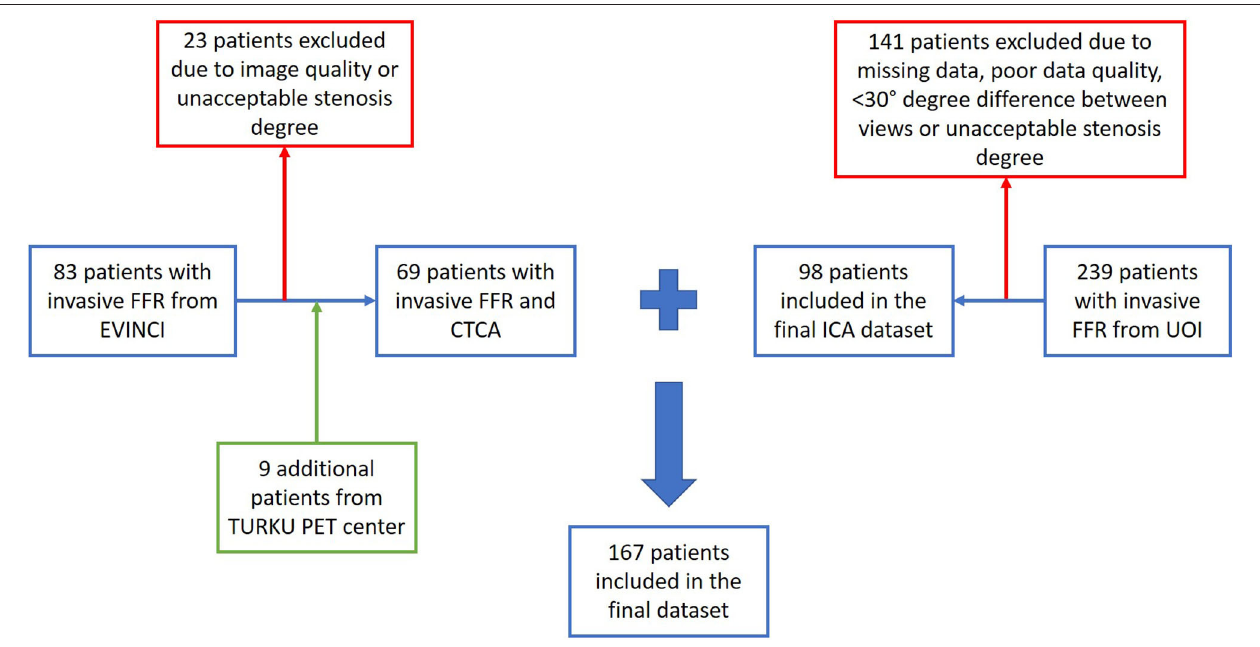
FIGURE 1 | Enrollment and diagnostic